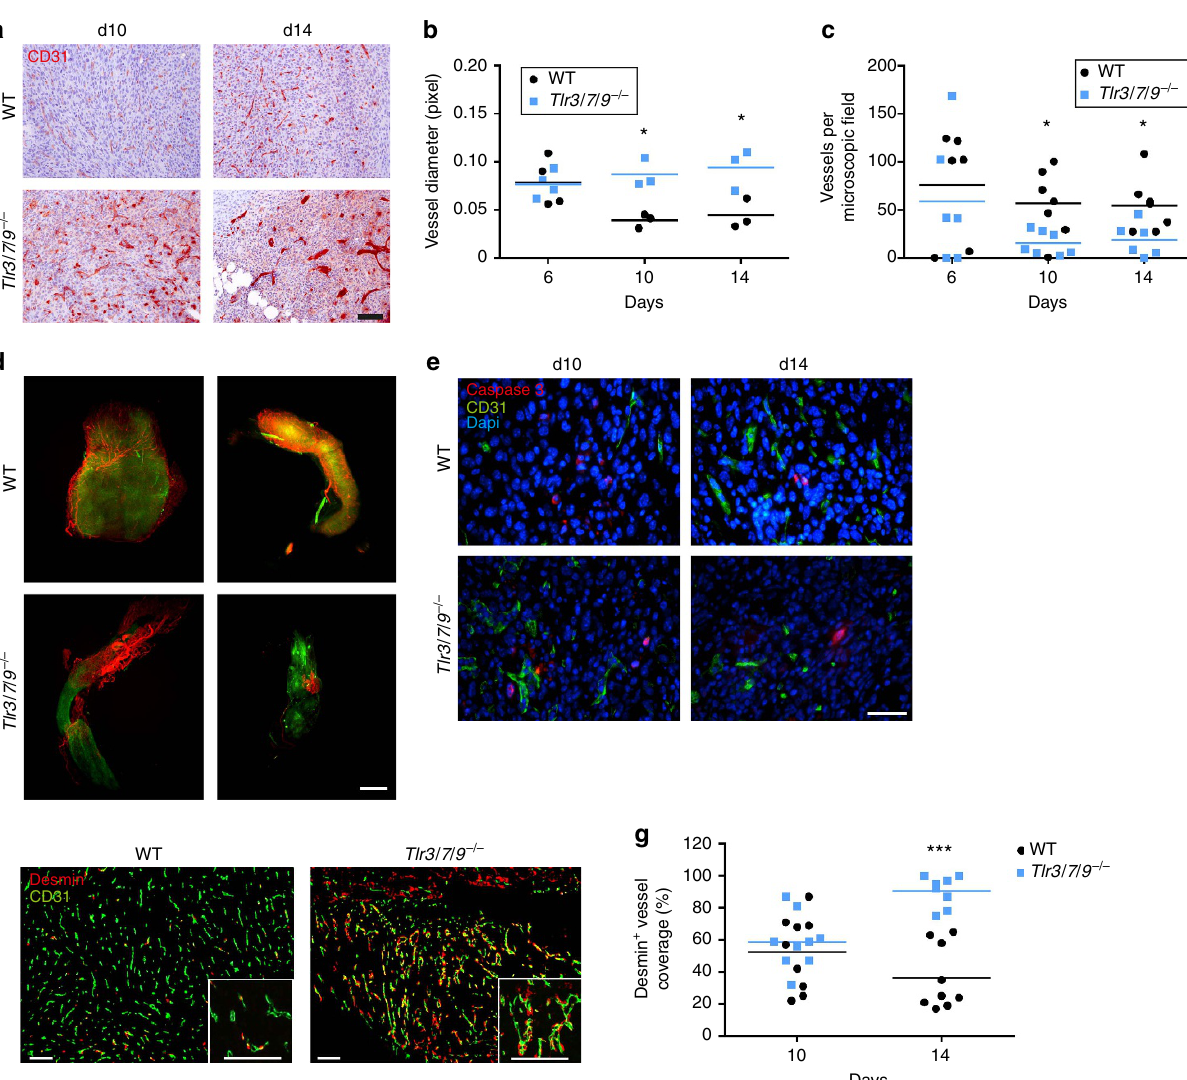
Figure 3 | Increased vessel diameter and pericyte coverage in Tlr (cid:2) / (cid:2) mice. ( a – c ) Frozen sections of s.c. tumours dissected at day 6, day 10 or 14 after injection were stained with a CD31 antibody, to assess the vascular system of tumours of 8- to 16-week-old C57BL/6 WT and Tlr3/7/9 (cid:2) / (cid:2) mice. ( a ) Representative examples of tumours at day 10 und day 14. Scale bar, 100 m m. ( b ) For analysis of vessel diameter, vessels were assessed manually in (cid:3) 200 magnified images and diameter was quantified using ImageJ software ( n ¼ 3). P -value ( t -test) is indicated (* P r 0.05). Single values and mean